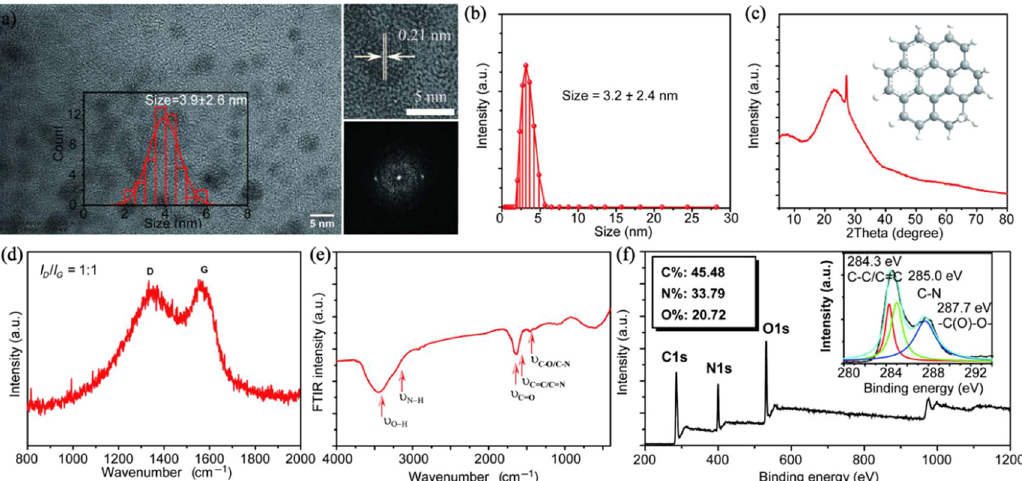
Figure 1: (a) Transmission electron microscopy (TEM) images, high-resolution TEM (HRTEM) images, and selected area electron diffraction (SAED)patternofthecarbonnanodots(CDs)(inset:thesizedistributionoftheCDs).(b)DLSoftheCDsaqueoussolution.(c)XRDpatternofthe CDs.(d)RamanspectrumoftheCDspowder.(e)FTIRspectrumoftheCDs.(f)SurveyXPSspectrumoftheCDsandhigh-resolutionC1sspectrum of the CDs.